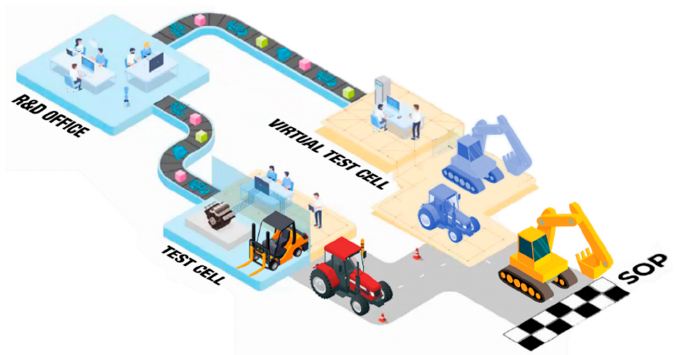
Figure 1. Virtualization process to reduce ICE development cost and timing and to go faster to Start of Production (SOP) stage.